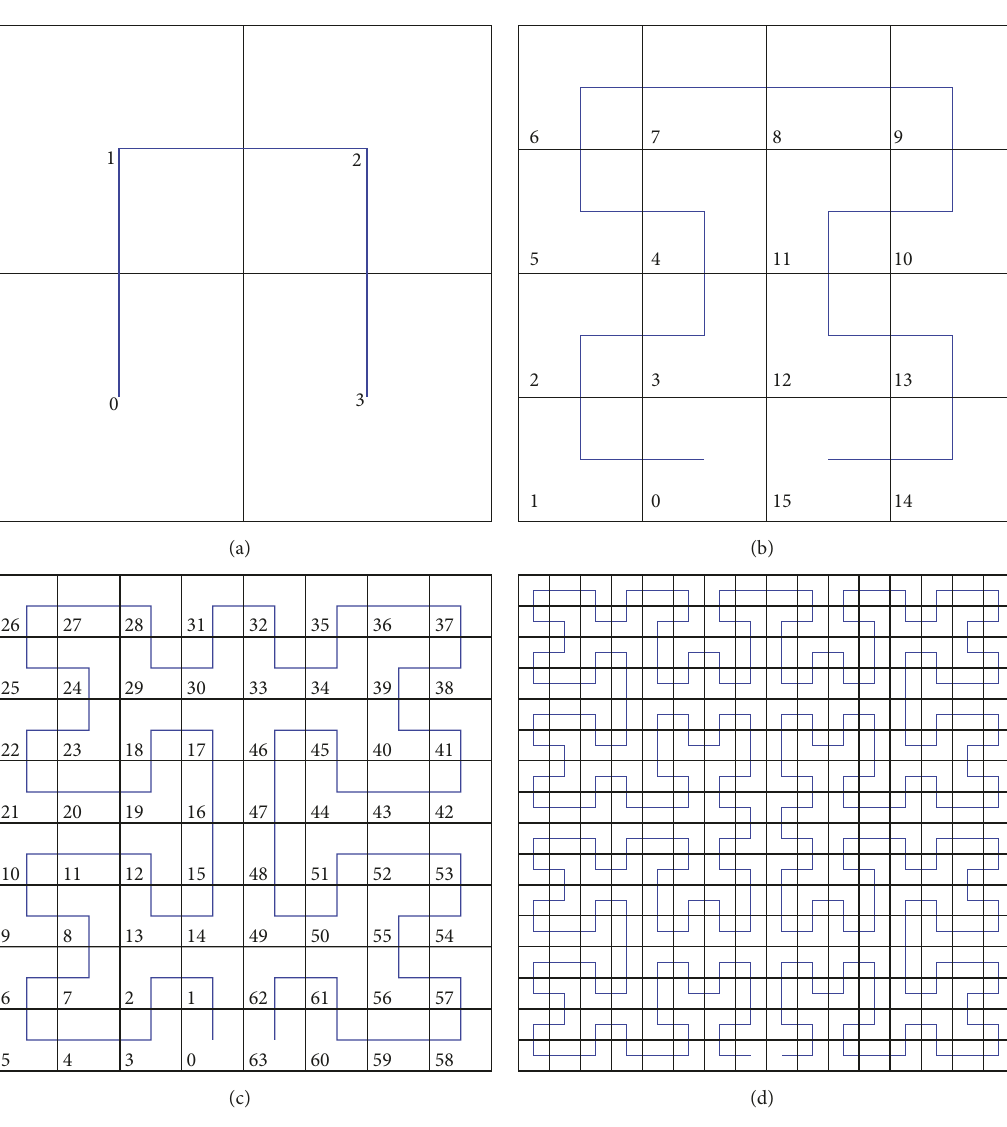
Figure 2: (a) Moore curve of order 𝑁 = 1 . (b) Moore curve of order 𝑁 = 2 . (c) Moore curve of order 𝑁 = 3 . (d) Moore curve of order 𝑁 = 4